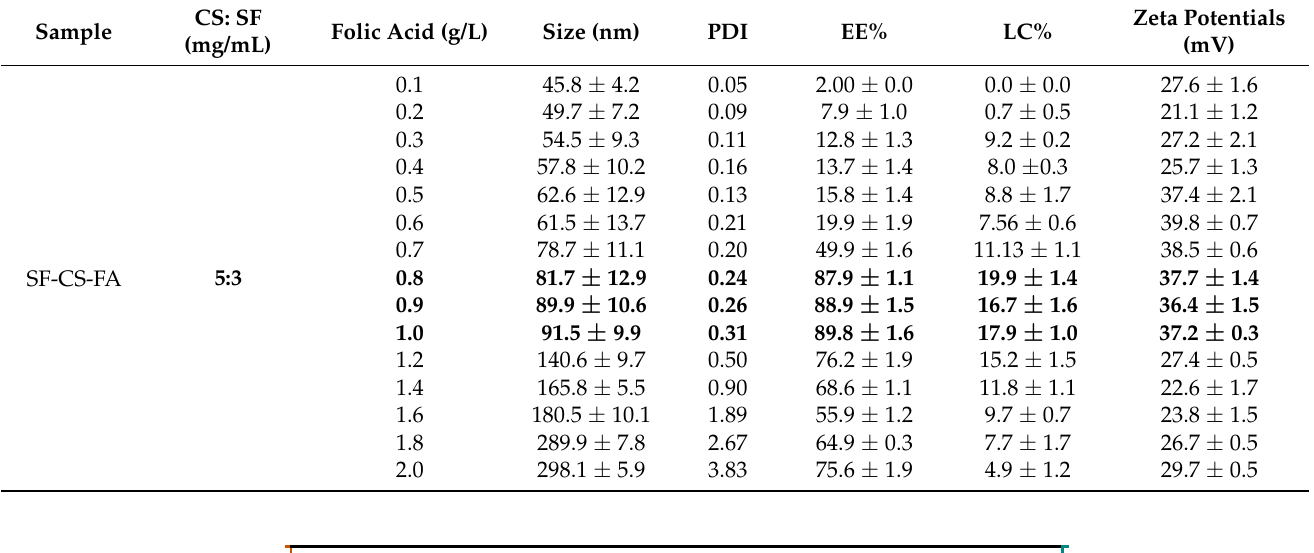
Table 2. The effect of size, poly dispersity index, encapsulation efficiency (%) and loading content (%), and zeta potential of the SF-CS nanoparticles after coating them with folic acid for the formation of SF-CS-FA nanoparticles. Optimal parameters are shown in bold.